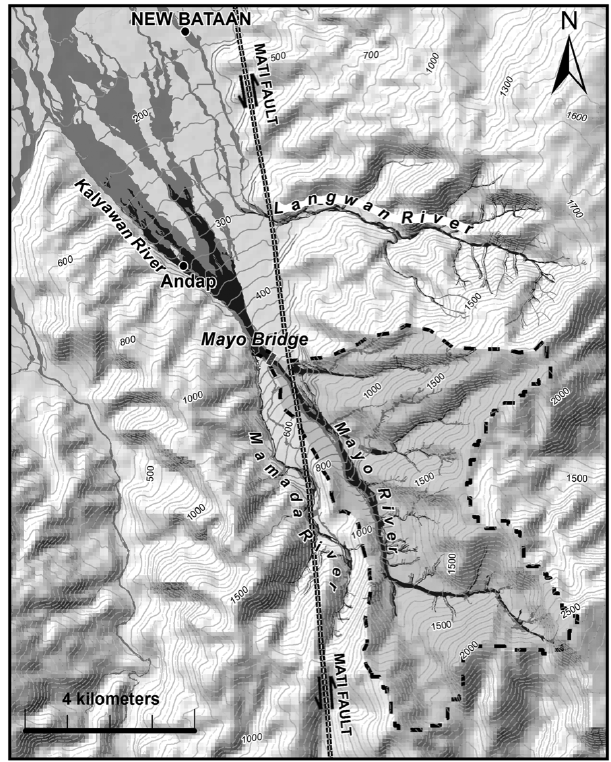
Figure 2. Physical setting of the Andap disaster. Grey area enclosed by dashes is the Mayo watershed. All steep slopes are contoured at 50m intervals. Below 700m elevations the contour interval is 20m to better define the gentler valley surfaces. New deposits of true debris flows south of the Mayo bridge are shown in solid black; associated hyperconcentrated-flow deposits are shaded in grey. Note that the topographic contour lines from the Mayo bridge to New Bataan are convex northward, defining the surface of an alluvial fan. The trace of the Mati Fault is only generalized; it has numerous associated fractures in a broad zone along its length.